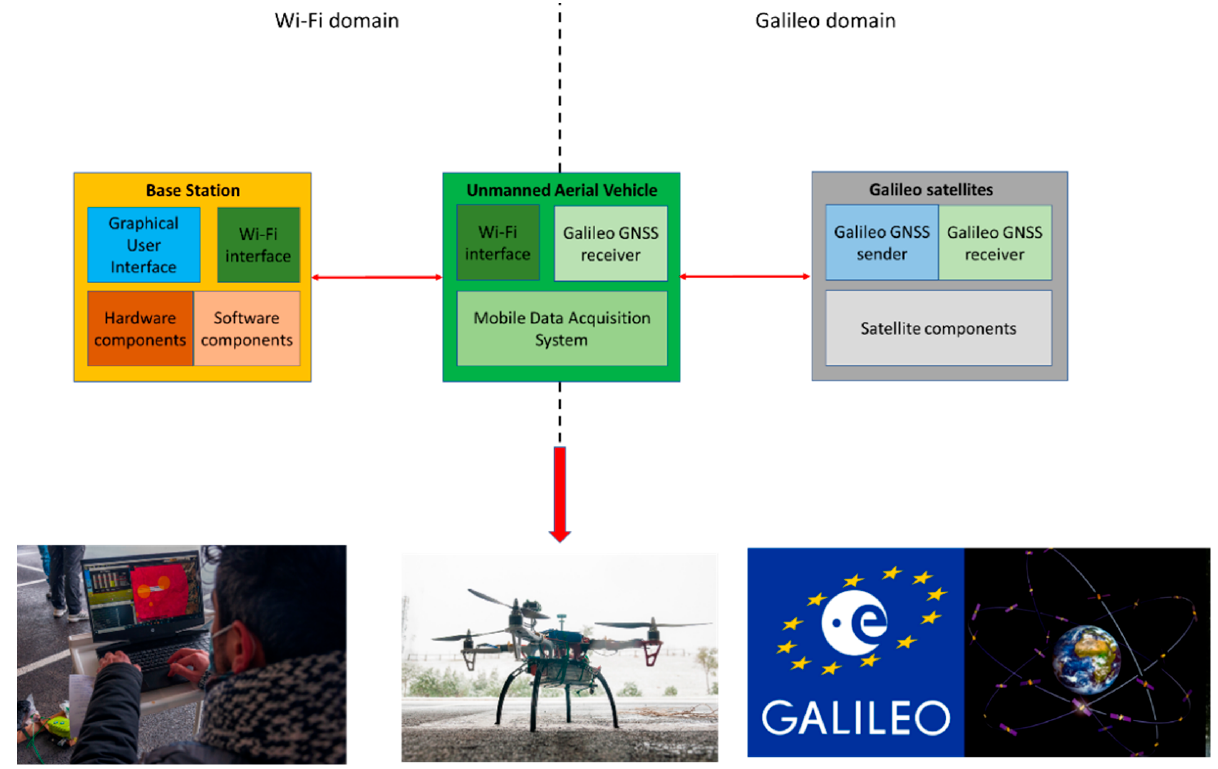
Figure 1. Components used in the proposed system.